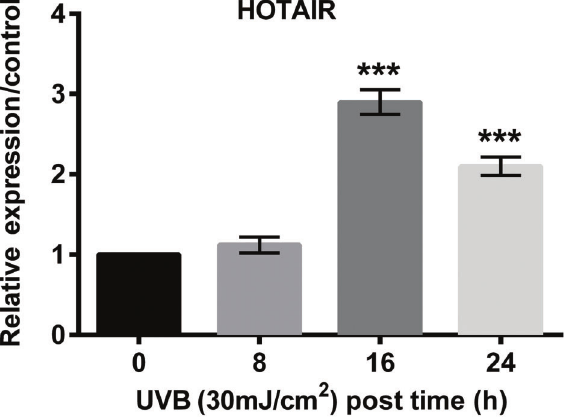
Figure 2. qRT-PCR was performed to evaluate the effect of UVB on HOTAIR and data revealed that UVB upregulated the expression of HOTAIR. Data are reported as means ± SD. ***P o 0.001, compared to control (0 UVB) (ANOVA). qRT-PCR: quantitative real-time polymerase chain reaction; UVB: ultraviolet B; HOTAIR: HOX antisense intergenic